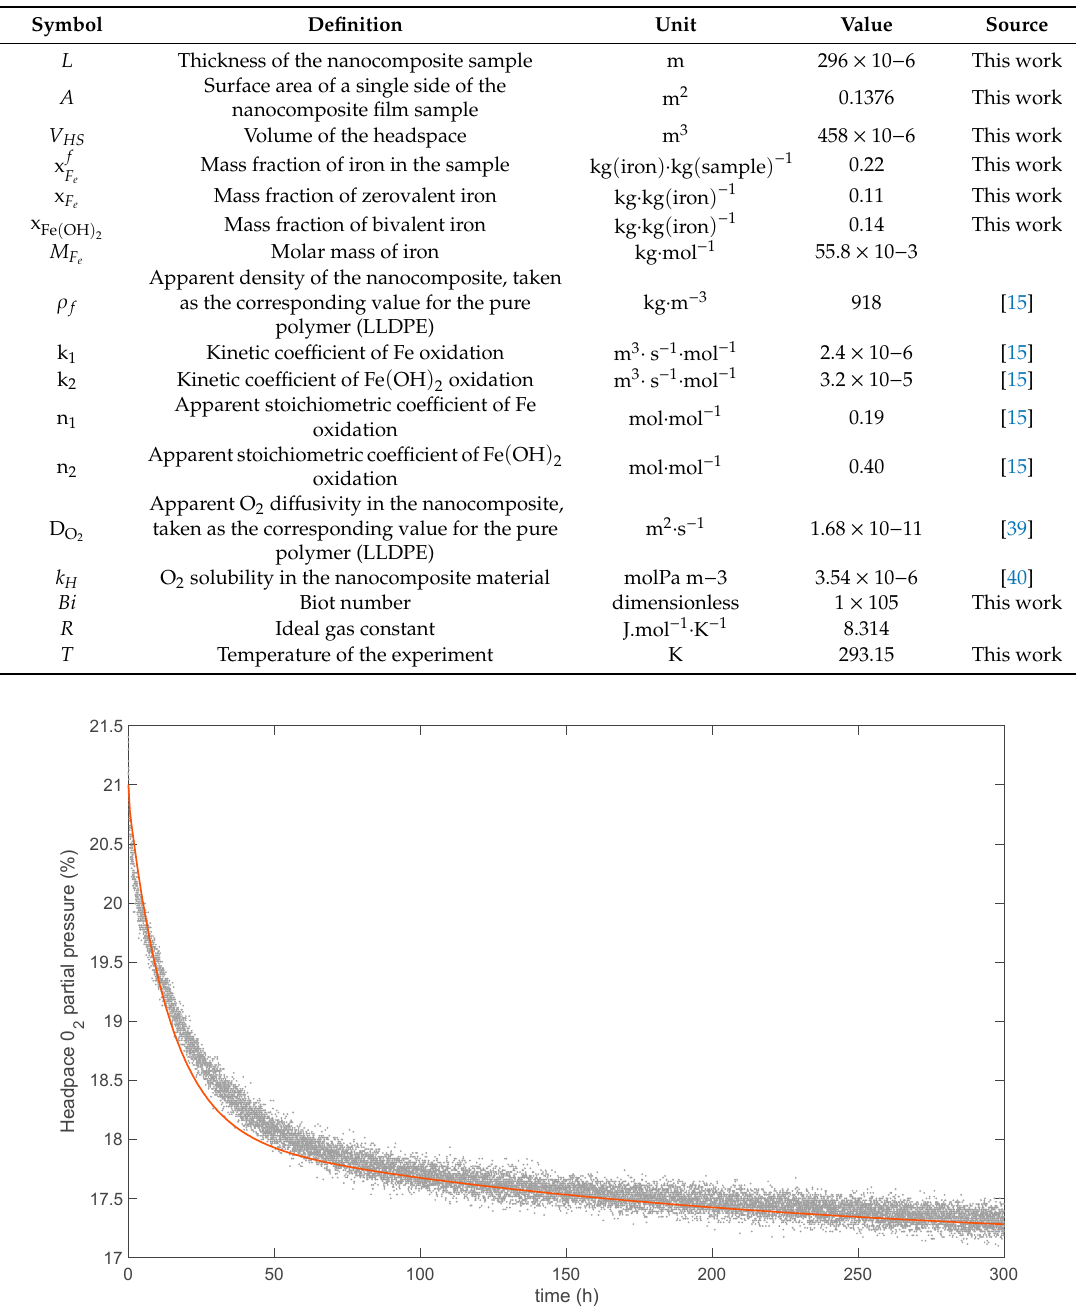
Table 5. Parameter descriptions and values for numerical simulation of O 2 adsorption for the PE.Fu15.MMT-Fe6.25 sample.